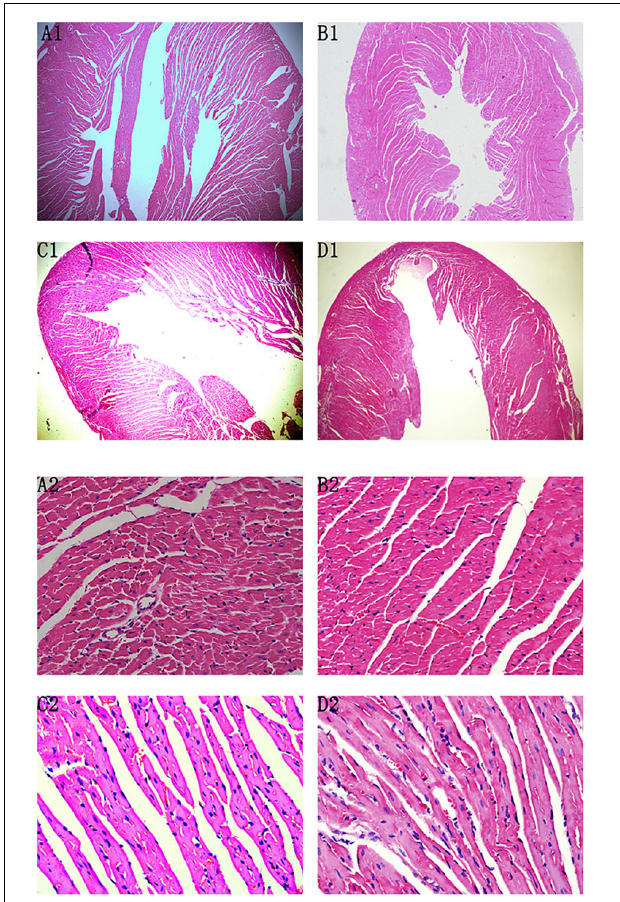
FIGURE 5 | HE staining on the 72nd day. The heart chambers were shrunken and less interstitial fibroblasts infiltrated after treatment with ivabradine (IVA) in CVMC+IVA group as compared to that in CVMC2 group. (A) Normal control 2 group, (B) Normal+IVA group, (C) CVMC+IVA group, and (D) CVMC2 group.